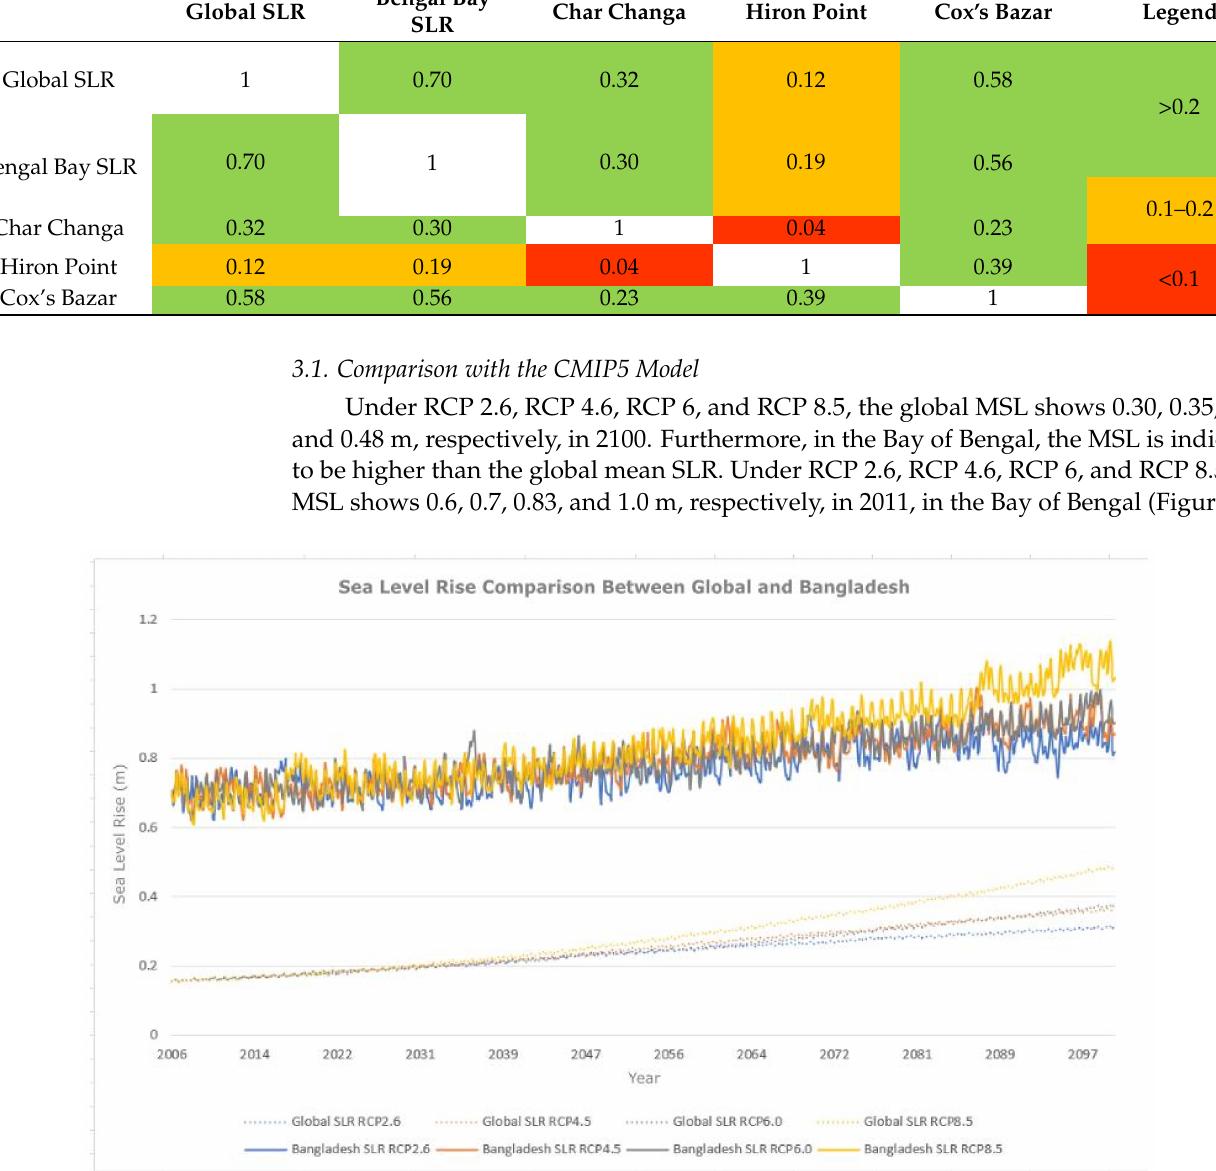
Figure 6. Projected time series of global mean sea level rise and mean sea level rise over Bay of Bengal for different representative concentration pathways (RCPs) (NorESM1-EM model from CMIP5)